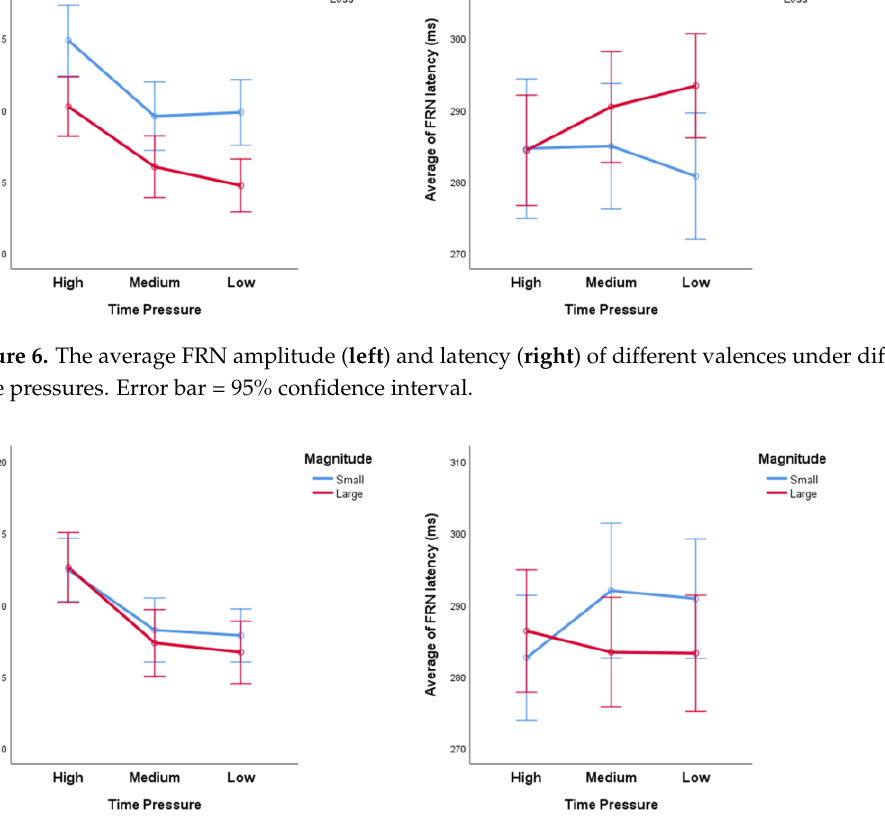
Figure 7. The average FRN amplitude ( left ) and latency ( right ) of different magnitudes under Figure 7. The average FRN amplitude (left) and latency (right) of different magnitudes under dif- different time pressures. Error bar = 95% confidence ferent time pressures . Error bar = 95% confidence interval. Figure 7. The average FRN amplitude (left) and latency (right) of different magnitudes under dif- Figure 7. The average FRN amplitude (left) and latency (right) of different magnitudes under dif- ferent time pressures . Error bar = 95% confidence interval. ferent time pressures . Error bar = 95% confidence interval.